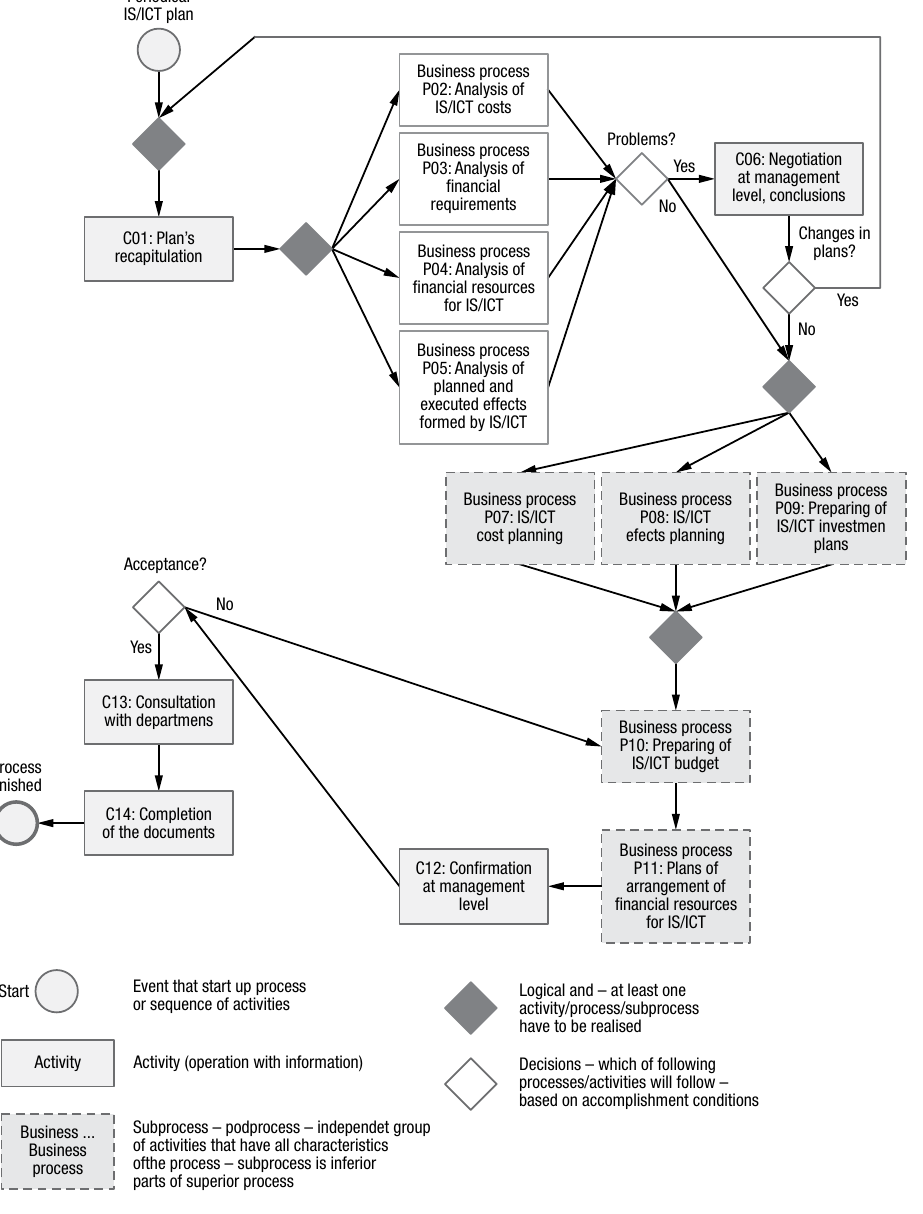
Fig. 3. Main process of business informatics economics